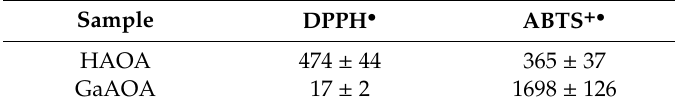
Figure 5. Radical-scavenging activities (RSAs) of HAOA (curves 1) and GaAOA (curves 2) toward ( a ) 2,2-diphenyl-1-picrylhydrazyl radical (DPPH • ) and ( b ) 2,2 ′ -azino-bis(3-ethylbenzothiazoline-6- sulphonic free radical (ABTS • + ). Data = mean ± SD ( n = 5). *, statistically significant di ff erence from HAOA ( p < 0.05). Table 1. IC 50 trolox equivalents (TEs) per milligram investigated substance (TE/mg) for HAOA and GaAOA. Higher values correspond to greater radical-scavenging activity.